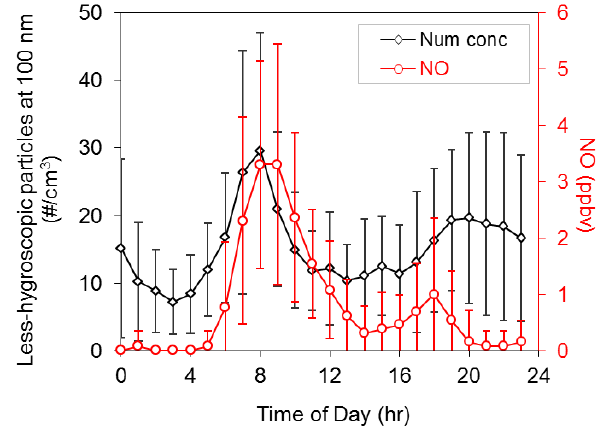
Figure 9. Diel variations in less-hygroscopic particles at dry D p =100nm, and NO concentrations during the entire measurement periods. Error bars represent 1 σ of number concentration of less- soluble particles at dry D p =100nm and NO